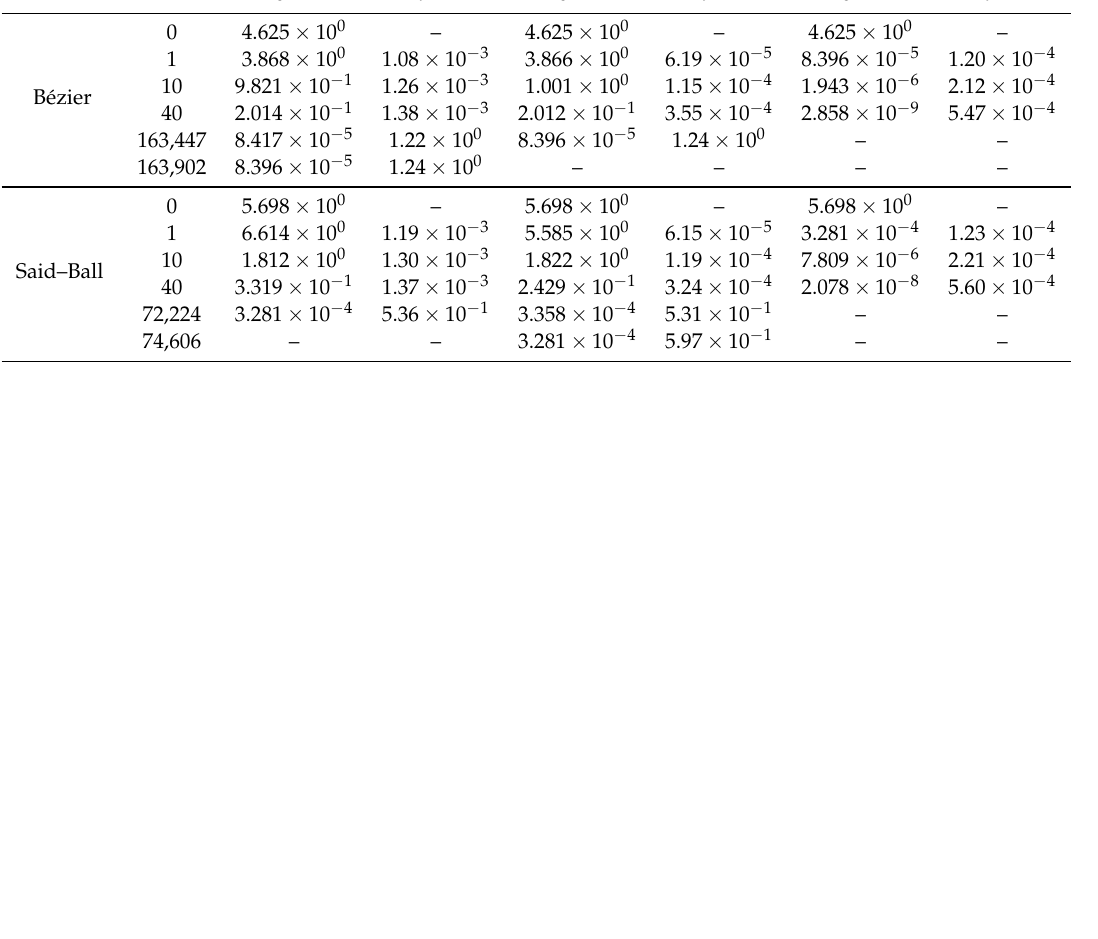
Table 3. The approximation errors and runtime of WPIA, DWPIA and PPIA in Example 2.